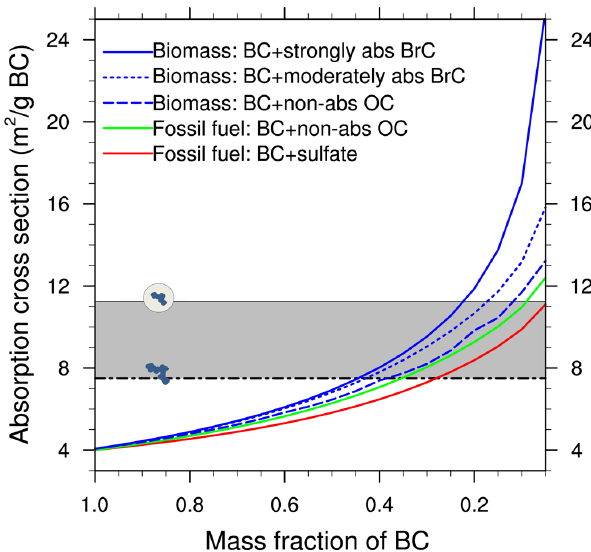
Fig. 2. The enhancement in absorption cross section (m 2 g − 1 BC) at 550nm, calculated for coated BC particles in dry conditions. The composition of the coating material is assumed to be sulfate (red) or non-absorbing OC (green) for fossil fuel aerosol. For biofuel and biomass burning aerosols the coating is non-absorbing OC (blue dashed), or moderately absorbing BrC (blue dotted), or strongly absorbing BrC (blue solid). Also shown in gray shading are val- ues for BC aggregates (7.5m 2 g − 1 ) and aged BC with coatings (11.25m 2 g − 1 ) recommended by Bond and Bergstrom (2006) and Bond et al.